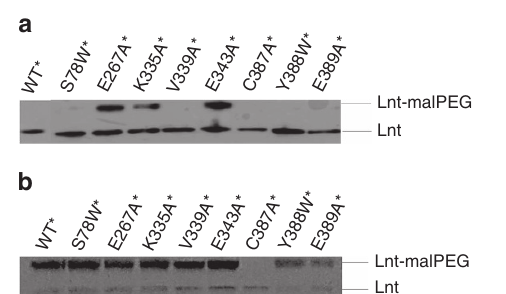
Figure 4 | Effects of different mutated residues on the acylation activity of Lnt. Eight key residues that caused dysfunction of Lnt in the in vivo assay were combined in the C23A/C62A variant of Lnt (that is, WT*) and were analysed by mal-PEG alkylation. Lnt (C23A/C62A/C387A), that is, C387A*, lacks any cysteine residue and was used as a negative control. Whole-cell lysates were treated without ( a ) or with ( b ) 1M neutral hydroxylamine (which reduces all thioester bonds) and subsequently treated with mal-PEG. Samples were analysed by SDS-10% polyacrylamide gel electrophoresis followed by immunoblotting with antibodies against polyHis-tag. Alkylated (Lnt-mal-PEG) and non-alkylated forms of Lnt are indicated. Note that, variants E267A, K335A, E343A, C387A and E389A have been reported to be inactive using the same assay 18 .